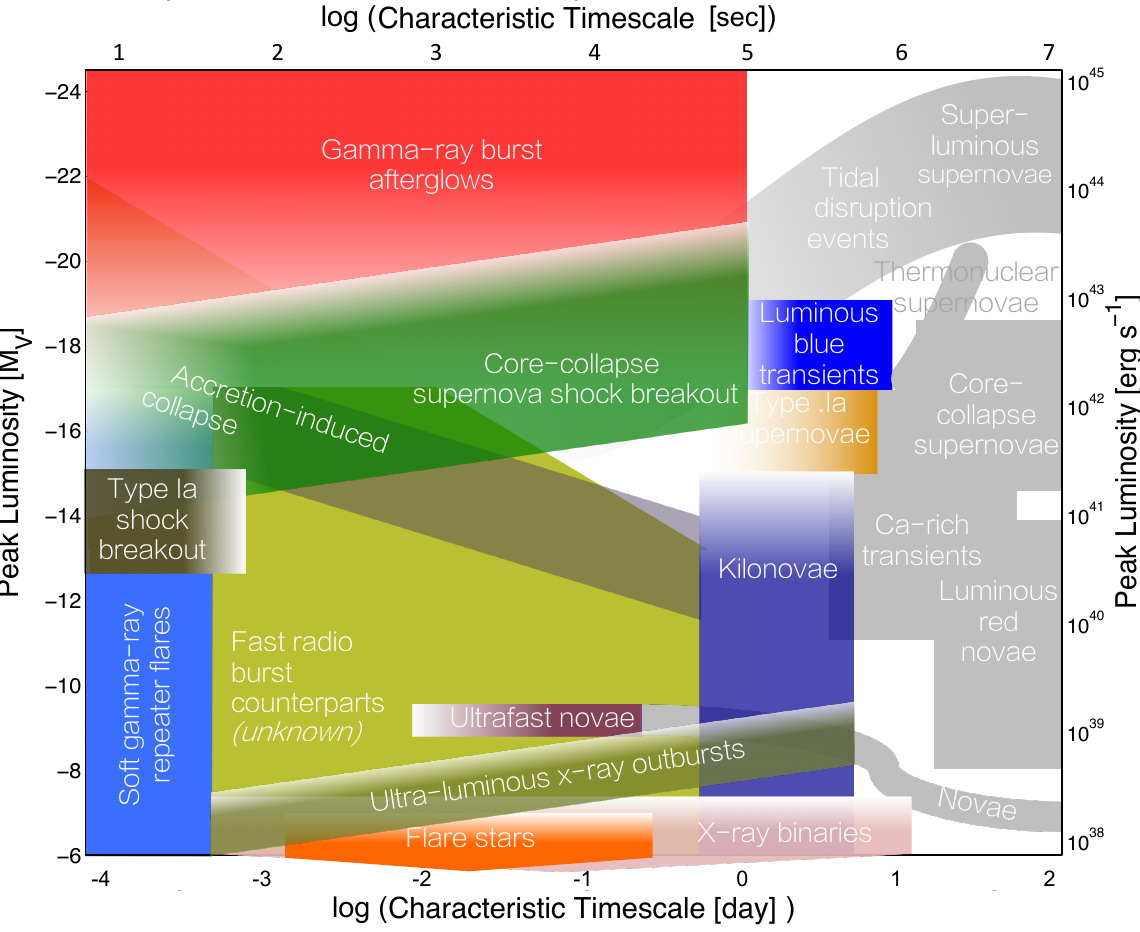
Characteristic Timescale [day] Figure 1. Luminosity – Timescale plot for transient phenomena, with approximate characteristic timescales and peak Figure 4. Framework of Cosmic Explosions in the Year 2011 (Kasliwal 2011). Note that until 2005 (Fig. 1), Figure 4. Framework of Cosmic Explosions in the Year 2011 (Kasliwal 2011). Note that until 2005 (Fig. 1), Figure 4. Framework of Cosmic Explosions in the Year 2011 (Kasliwal 2011). Note that until 2005 (Fig. 1), luminosities (credit: Jeff Cooke/Swinburne University of we only knew about three classes (denoted by gray bands). In the past six years, systematic searches, we only knew about three classes (denoted by gray bands). In the past six years, systematic searches, we only knew about three classes (denoted by gray bands). In the past six years, systematic searches, serendipitous discoveries and archival searches have uncovered a plethora of novel, rare transients. Discov- serendipitous discoveries and archival searches have uncovered a plethora of novel, rare transients. Discov- serendipitous discoveries and archival searches have uncovered a plethora of novel, rare transients. Discov- eries by the Palomar Transient Factory and P60-FasTING (Kasliwal et al. 2011a) are denoted by ? . Several eries by the Palomar Transient Factory and P60-FasTING (Kasliwal et al. 2011a) are denoted by ? . Several eries by the Palomar Transient Factory and P60-FasTING (Kasliwal et al. 2011a) are denoted by ? . Several new classes are emerging and the governing physics is being widely debated: luminous red novae (electron new classes are emerging and the governing physics is being widely debated: luminous red novae (electron new classes are emerging and the governing physics is being widely debated: luminous red novae (electron capture induced collapse of rapidly rotating O–Ne–Mg white dwarfs?), luminous supernovae (magnetars capture induced collapse of rapidly rotating O–Ne–Mg white dwarfs?), luminous supernovae (magnetars capture induced collapse of rapidly rotating O–Ne–Mg white dwarfs?), luminous supernovae (magnetars of Cosmic Explosions in the Year 2011 (Kasliwal 2011). Note that until 2005 (Fig. 1), Figure 4. Framework or pair instability explosions?), .Ia explosions (helium detonations in ultra-compact white dwarf binaries), or pair instability explosions?), .Ia explosions (helium detonations in ultra-compact white dwarf binaries), or pair instability explosions?), .Ia explosions (helium detonations in ultra-compact white dwarf binaries), Calcium-rich halo transients (helium deflagrations?). we only knew about three classes (denoted by gray bands). Calcium-rich halo transients (helium deflagrations?). Calcium-rich halo transients (helium deflagrations?).